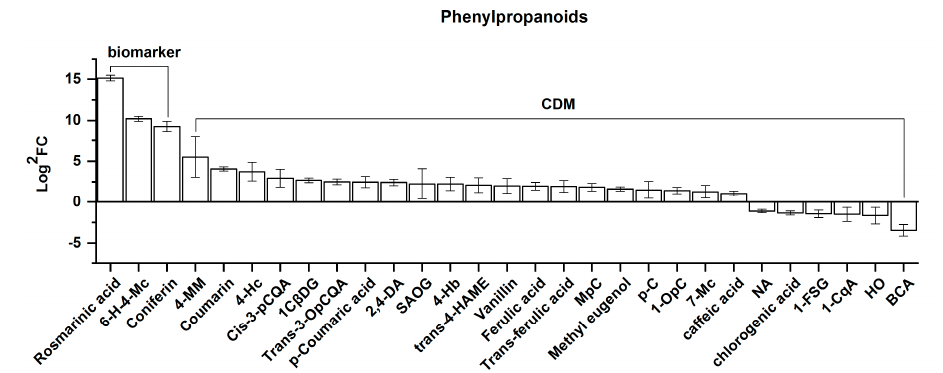
Figure 11. Comparison of phenylpropanoids, comprising 3 biomarkers and 26 CDMs between SJL and SN. Overall, 23 were upregulated and 6 were downregulated. Upregulation represents the content of a metabolite increasing in SN compared with that in SJL, and the opposite for downregulation. The Y -axis shows Log 2 FC values for the convenience of visual presentation (note that the up and down amplitudes in the text refer to the FC value). The X -axis denotes the metabolite